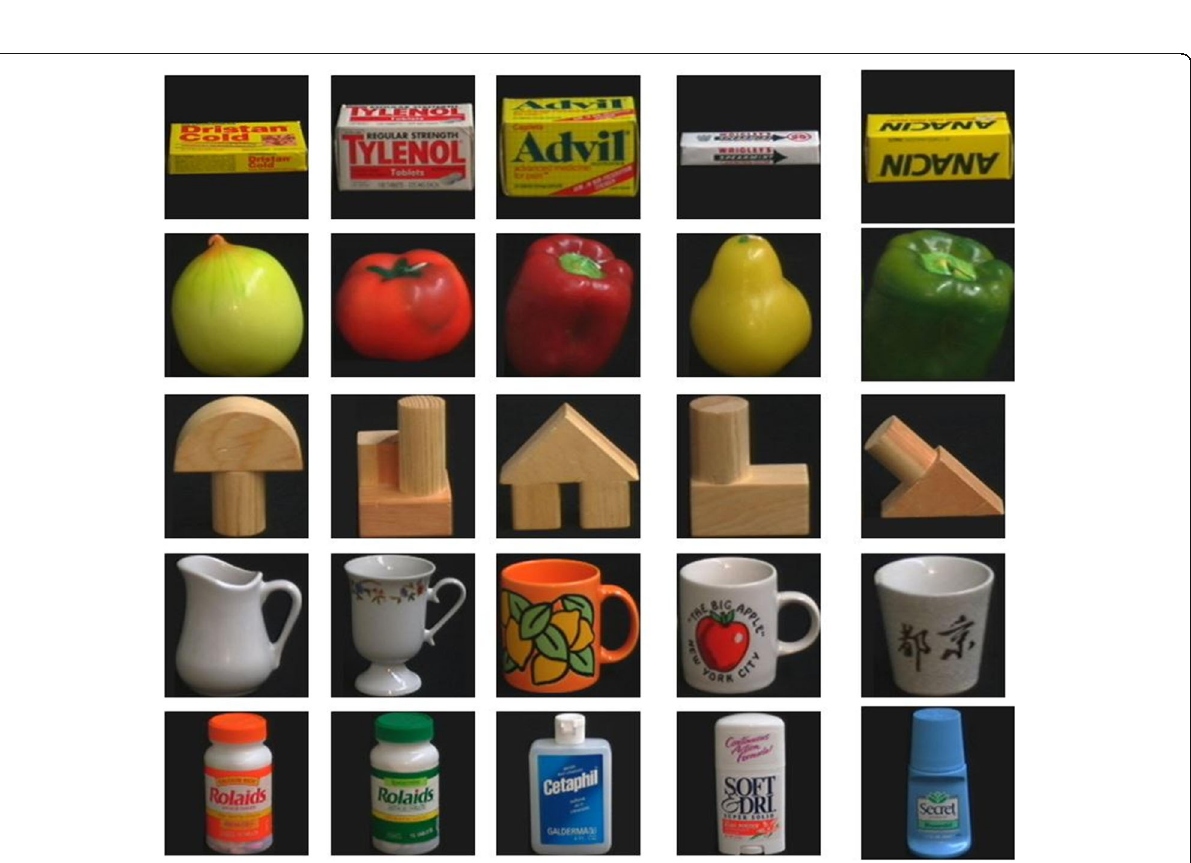
Fig. 17 Some typical color images of Coil-100 from Columbia